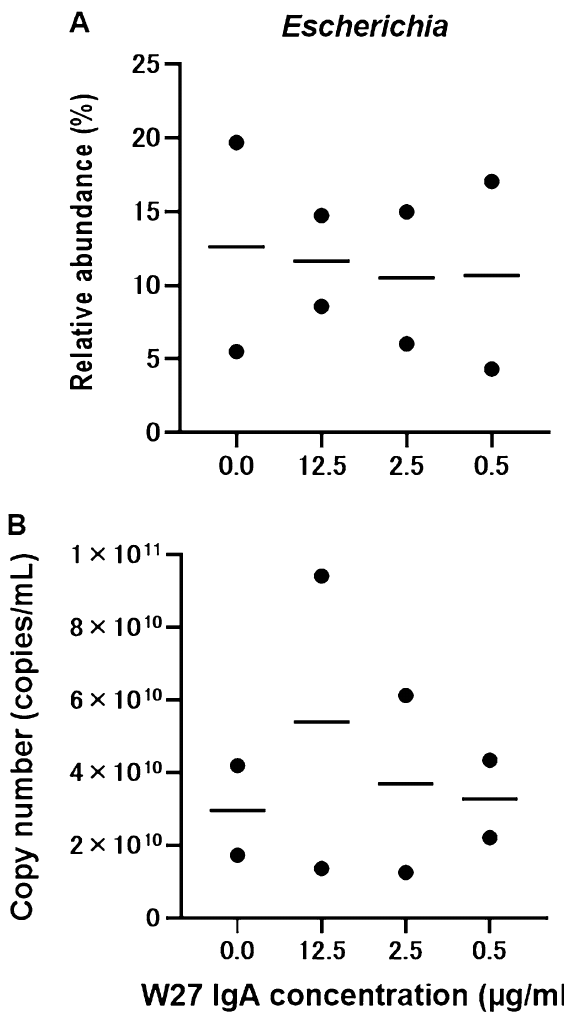
Figure 1. ( A ) Relative abundance and ( B ) absolute copy number of bacteria related to genus Escherichia in an in vitro human colonic microbiota model (KUHIMM) without (0.0 µg/mL) and with W27 IgA (12.5, 2.5, and 0.5 µg/mL) after 48 h of fermentation. The bars shown represent mean of two technical/biological replicates. Escherichia copy number = (Total copy number) × (Relative abundance).